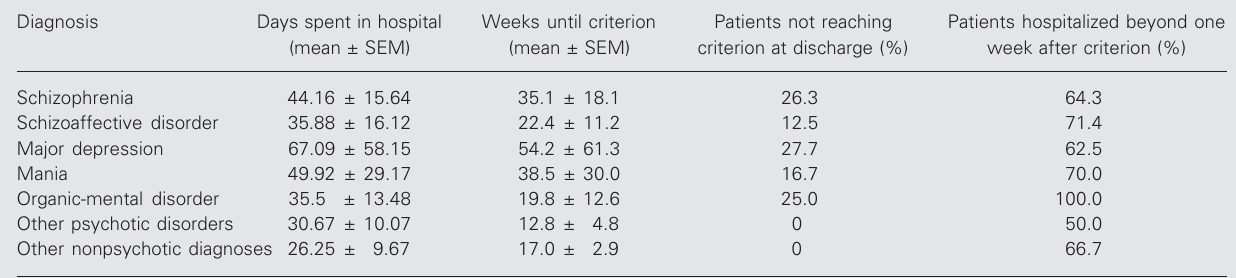
Table 2. Length of stay of patients admitted to the Psychiatric Unit of the Ribeirão Preto General Hospital during the second semester of 1994 as a function of diagnosis and discharge criterion (BPRS score ≤ 6).